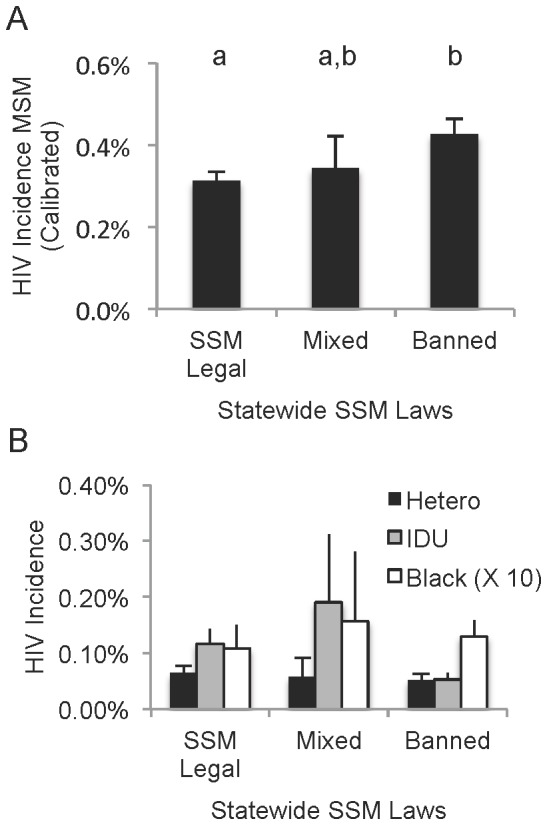
Stigmatization of homosexual behavior (as measured by statewide laws on same sex marriage (SSM)) correlates with increased MSM HIV incidence.Cities were assigned stigma categories based on their state's position on SSM as of July, 2013. States with legal marriage include 22 cities. States with civil unions, enumerated privilege (with or without constitutional SSM bans) or no relevant laws classified as “mixed” (n = 9 cities). States with legislative or constitutional SSM bans (n = 48 cities) were classified as “banned.” A. MSM HIV incidence rates represent total HIV reports by single MSM exposure divided by the estimated total GLB individuals per city (from Gates, 2006). Lowercase letters indicate statistically similar populations (by T-test, p>0.05). B. No pattern or significant difference was found in any other group (shown: HIV incidence by heterosexual or IDU exposure, and black individuals). Bars = SEM.